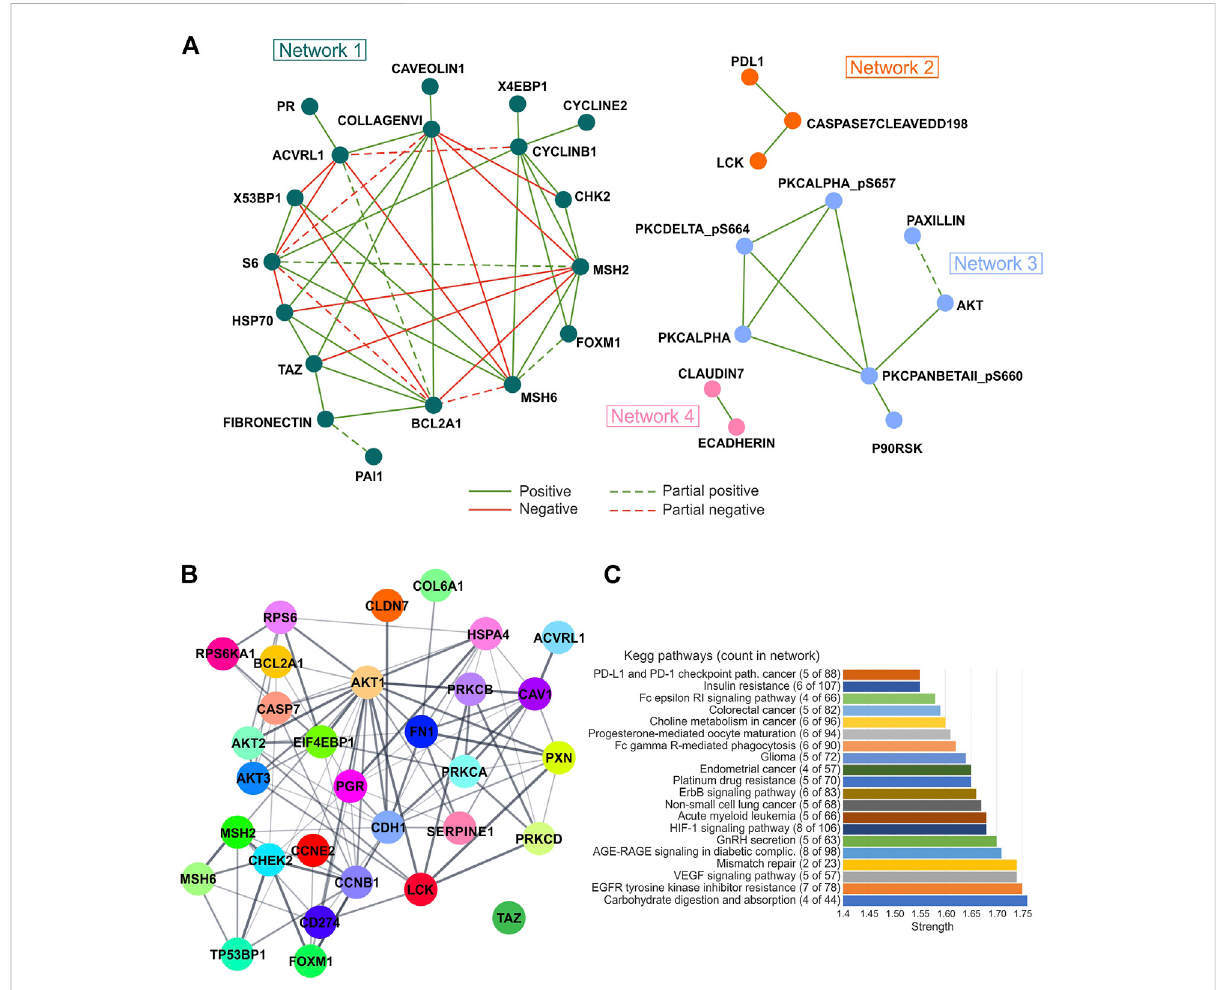
FIGURE 6 Correlation and pathway analysis of protein levels analyzed in each tumor type. (A) Protein – protein interaction showing correlation (Pearson ’ s r ≥ 0.3 or ≤ − 0.3; p ≤ 0.05) in at least 20 tumor types are represented. The concordance among Pearson ’ s value means was de fi ned as a degree of agreement among the correlation sign. Partial concordance: dotted interaction lines. Total concordance: solid interaction lines. The network was obtained from Cytoscape 3.8.2 (https://cytoscape.org/). (B) STRING network analysis (https://string-db.org/) of selected proteins signi fi cantly correlated with each other (Pearson ’ s r ≥ 0.3 or ≤ − 0.3; p ≤ 0.05). Edge thickness indicates the strength of data support. (C) Gene ontology analysis according to STRING algorithms. Strength of functional enrichments and count of proteins in each KEGG pathway are